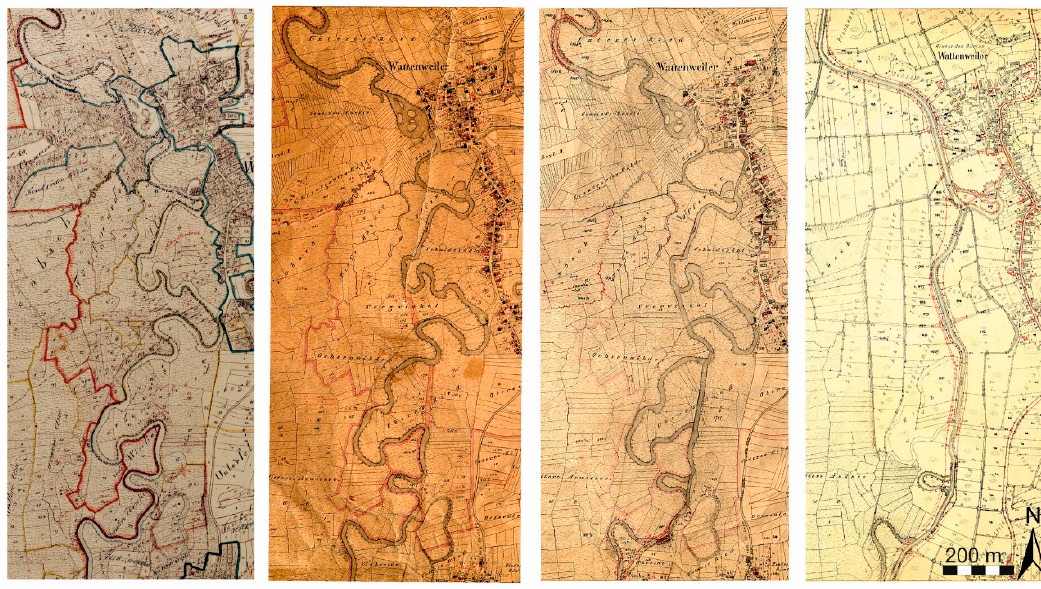
Figure 1. Visualisation of the changes in river morphology of the Günz river between 1823 and 1965 in the general parcelling map. Red lines in the plot of 1965 indicate the final and present condition of the channelization of the study area that was completed with the implementation of the power plant (PP) Wattenweiler in 1965.